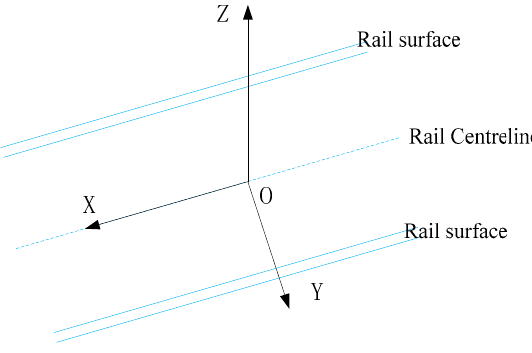
Figure 2. Definition of clearance coordinate system.